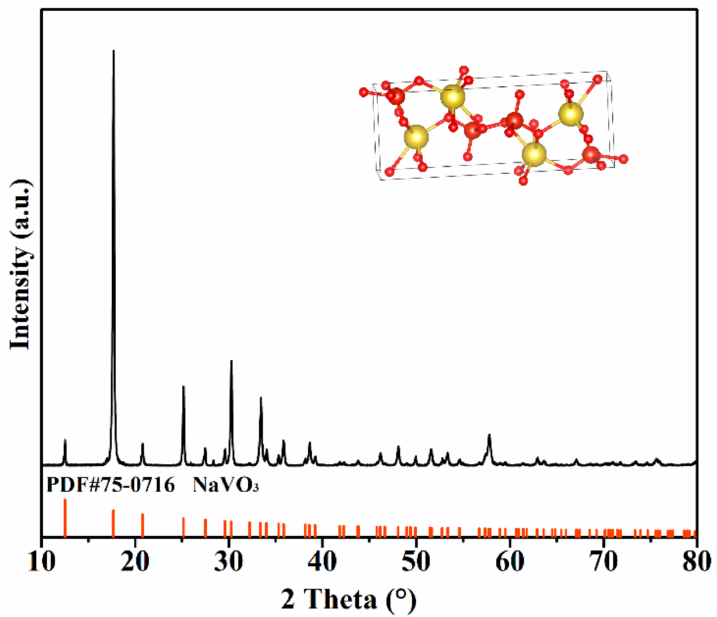
Figure 7. The XRD patterns of NaVO